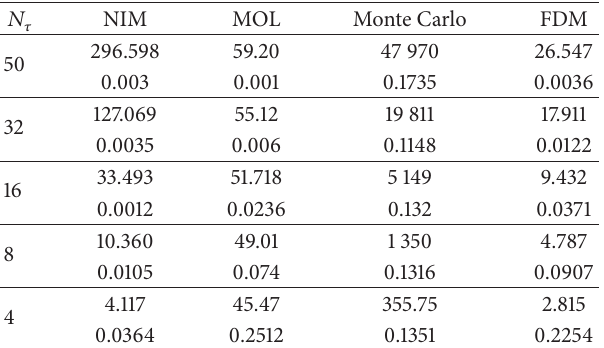
Table 3: CPU time in sec (first row) and absolute difference (second row) for different methods depending on number of time steps for fixed number of space steps for parameters